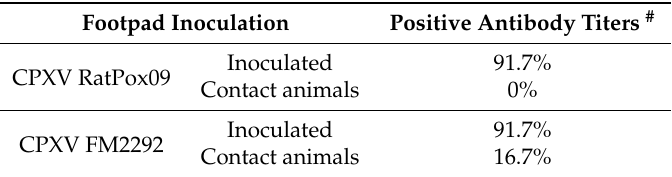
Table 6. Seroconversion rate of bank voles inoculated via the footpad method with either CPXV RatPox09 or CPXV FM2292 (28 dpi); details see Table S4. Footpad Inoculation Positive Antibody Titers # Inoculated 91.7% CPXV RatPox09 Contact animals 0% Inoculated 91.7% CPXV FM2292 Contact animals 16.7%